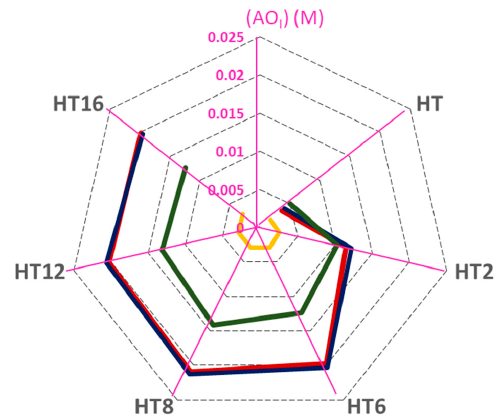
Figure 6. Radar chart presentation for the analysis of the effect of droplet size, O/W ratio, and emulsifier concentration on the interfacial antioxidant concentrations (from 0 to 0.025 M) which are indicated in each axis purple lines, expressed in terms of molarity (1:9 (O/W) emulsion at Φ I = 0.005; 1:9 (O/W) nanoemulsion at Φ I = 0.005; 4:6 (O/W) nanoemulsion at Φ I = 0.005; 1:9 (O/W) nanoemulsion at Φ I = 0.02). [AO T ] = 0.125 mM in 1:9 (O/W) emulsified systems and [AO T ] = 0.500 mM in 4:6 (O/W) emulsified system.